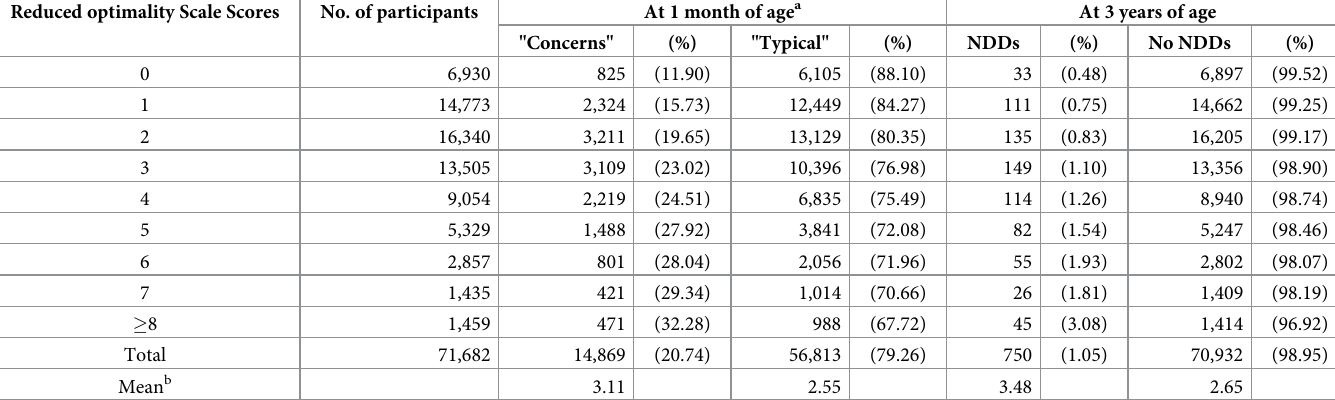
Table 4. Reduced optimality scale scores versus outcomes as assessed by parents at 1 month and versus diagnoses of neurodevelopmental disorders at 3 years of age. Reduced optimality Scale Scores